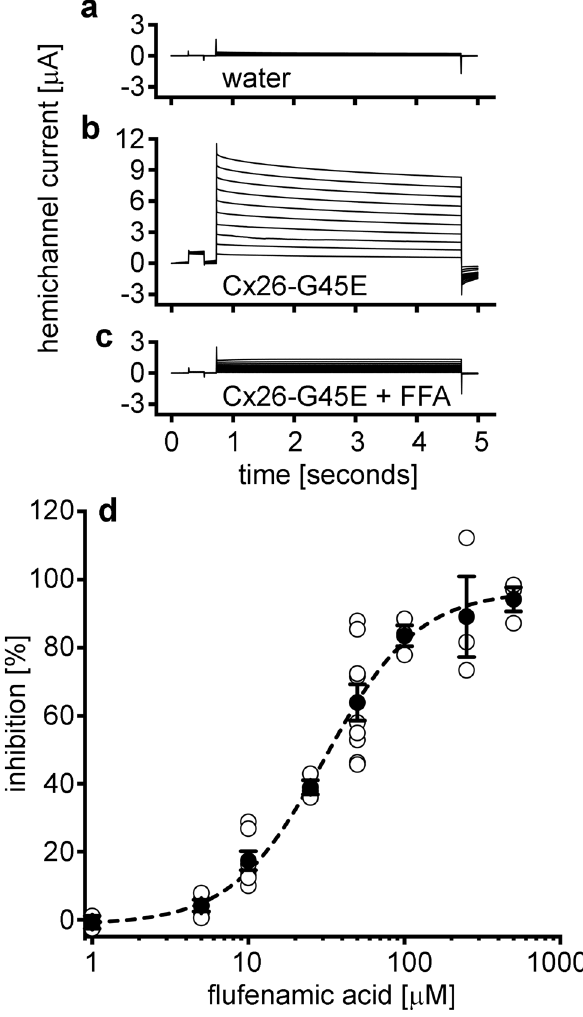
Figure 1. FFA blocked mutant Cx26-G45E hemichannels in vitro. ( a ) Control Xenopus oocytes injected with water instead of Cx26-G45E mRNA displayed no membrane hemichannel current. ( b ) Large hemichannel currents were recorded in oocytes injected with Cx26-G45E mRNA. ( c ) Perfusion of these cells with 50 µM FFA substantially inhibited the hemichannel currents. ( d ) Fitting of a dose response curve yielded an IC 50 ≈ 31 µM for FFA. n = 3–9 oocytes per tested FFA concentration. Filled symbols are means ± SE, open symbols are raw